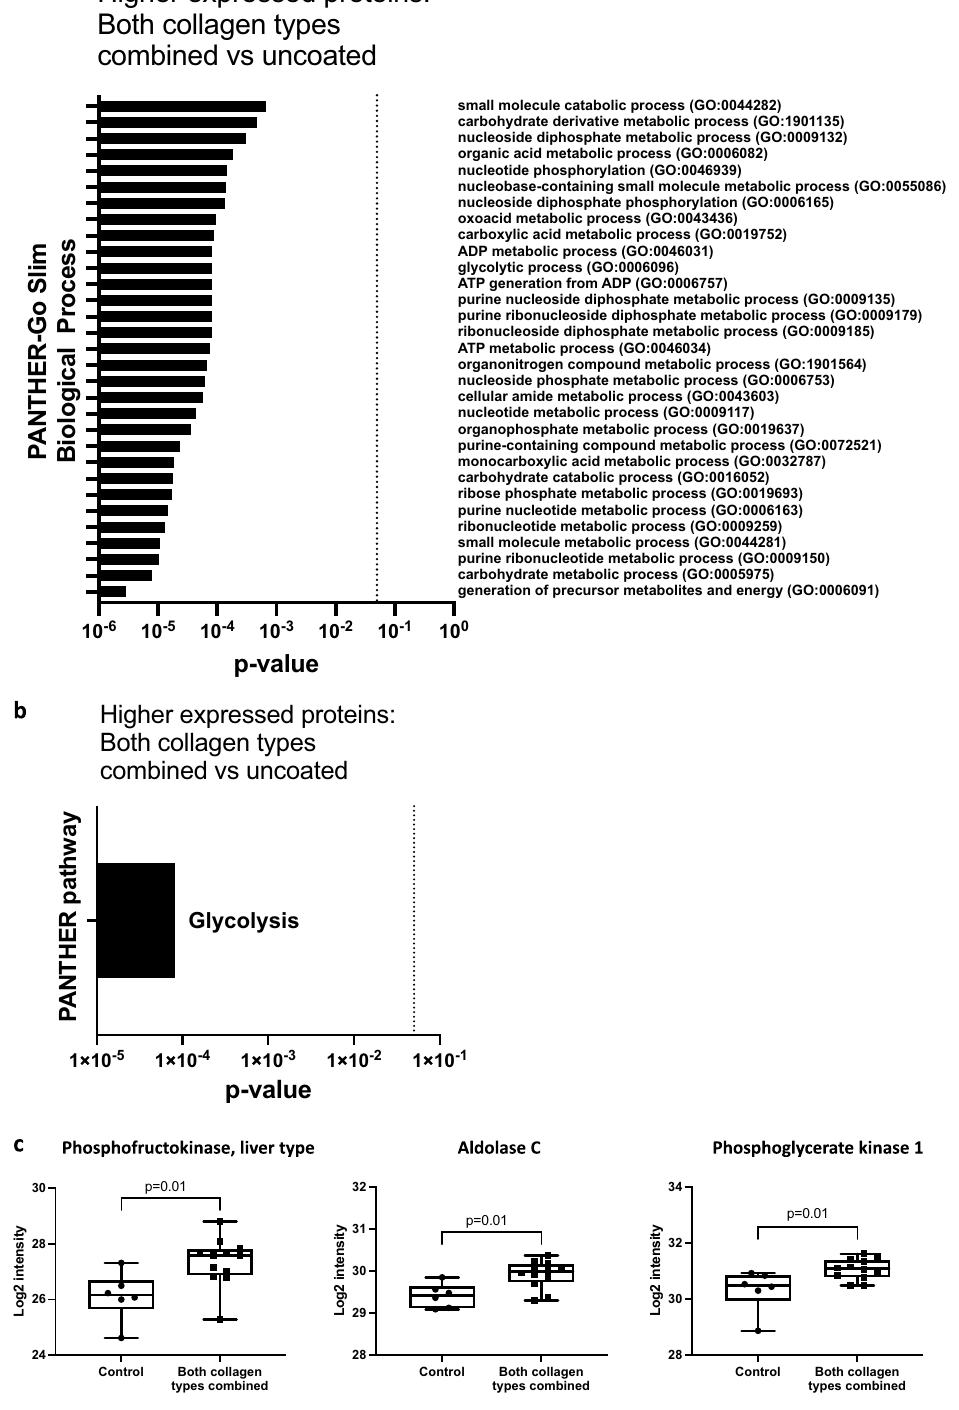
Figure 2. GO enrichment analysis of proteins upregulated by collagen type I. 69 proteins were > 1.25-fold upregulated by macrophages cultured on collagen-coated plates (fibrous and globular pooled), compared to uncoated controls. ( a ) PANTHER-Go Slim Biological Process analysis. ( b ) PANTHER pathway analysis, indicating significant enrichment of the glycolysis pathway. ( c ) Three proteins of the glycolysis pathway were significantly upregulated in macrophages grown on collagen (both types pooled, n = 6 each) compared to macrophages grown on plastic (control, n = 6). Protein intensity expressed as normalized Log2 values and statistically tested with an unpaired Wilcoxon test. p < 0.025 was considered significant. Data represented as a box and whiskers plot, where the box extends from the 25th to 75th percentiles and whiskers from min to max